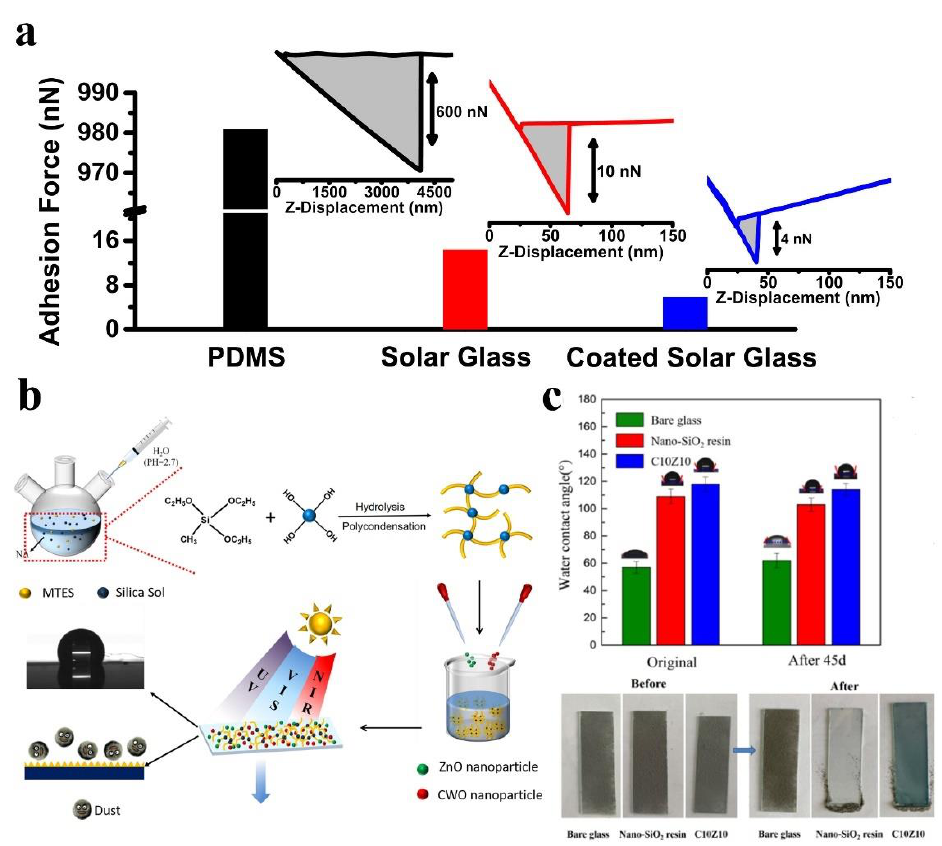
Figure 6. ( a ) Measurement of adhesion between dust particle and surface, reproduced with permission from Ref. [98]. ( b ) Preparation process and ( c ) anti-dust properties of anti-dust coating, reproduced with permission from Ref. [99].